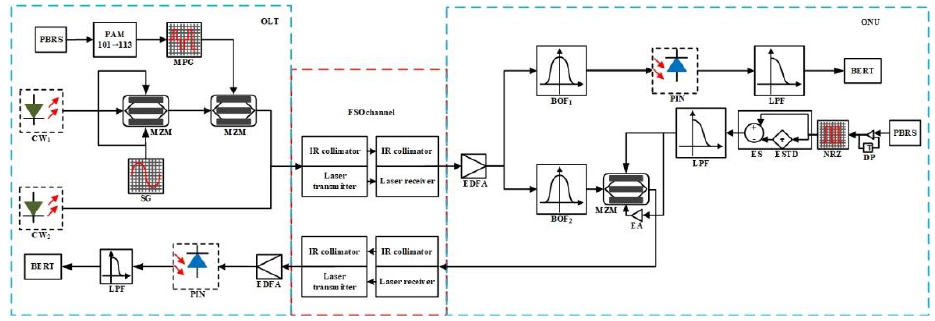
Fig. 1. High speed full duplex FSO transmission system using the downlink 67% duty cycle RZ- 4PAM and AMI uplink